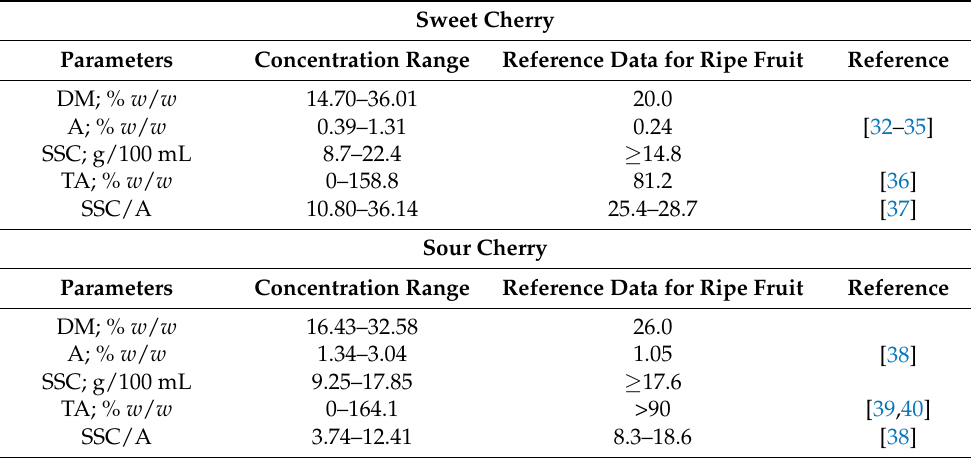
Table 3. Concentration ranges for sweet cherries and sour cherries and reference data for ripe